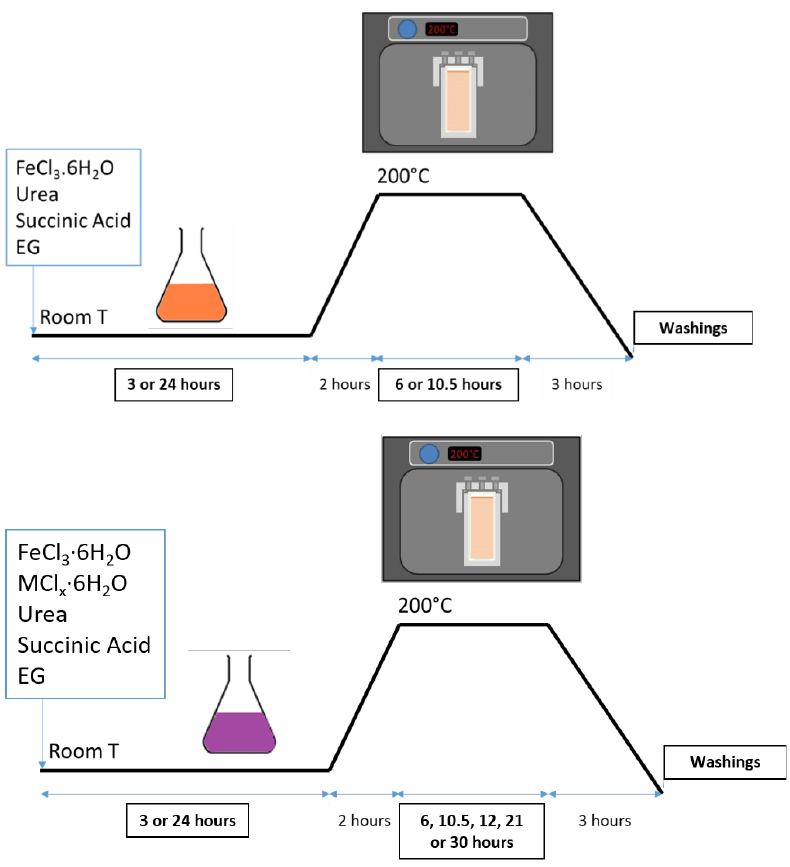
Figure 2. Synthesis conditions of RSNs (top) and of doped RSNs (down). EG: ethylene glycol. Doped RSNs. The same protocol as for the iron oxide RSNs was kept (Figure 2). Zinc